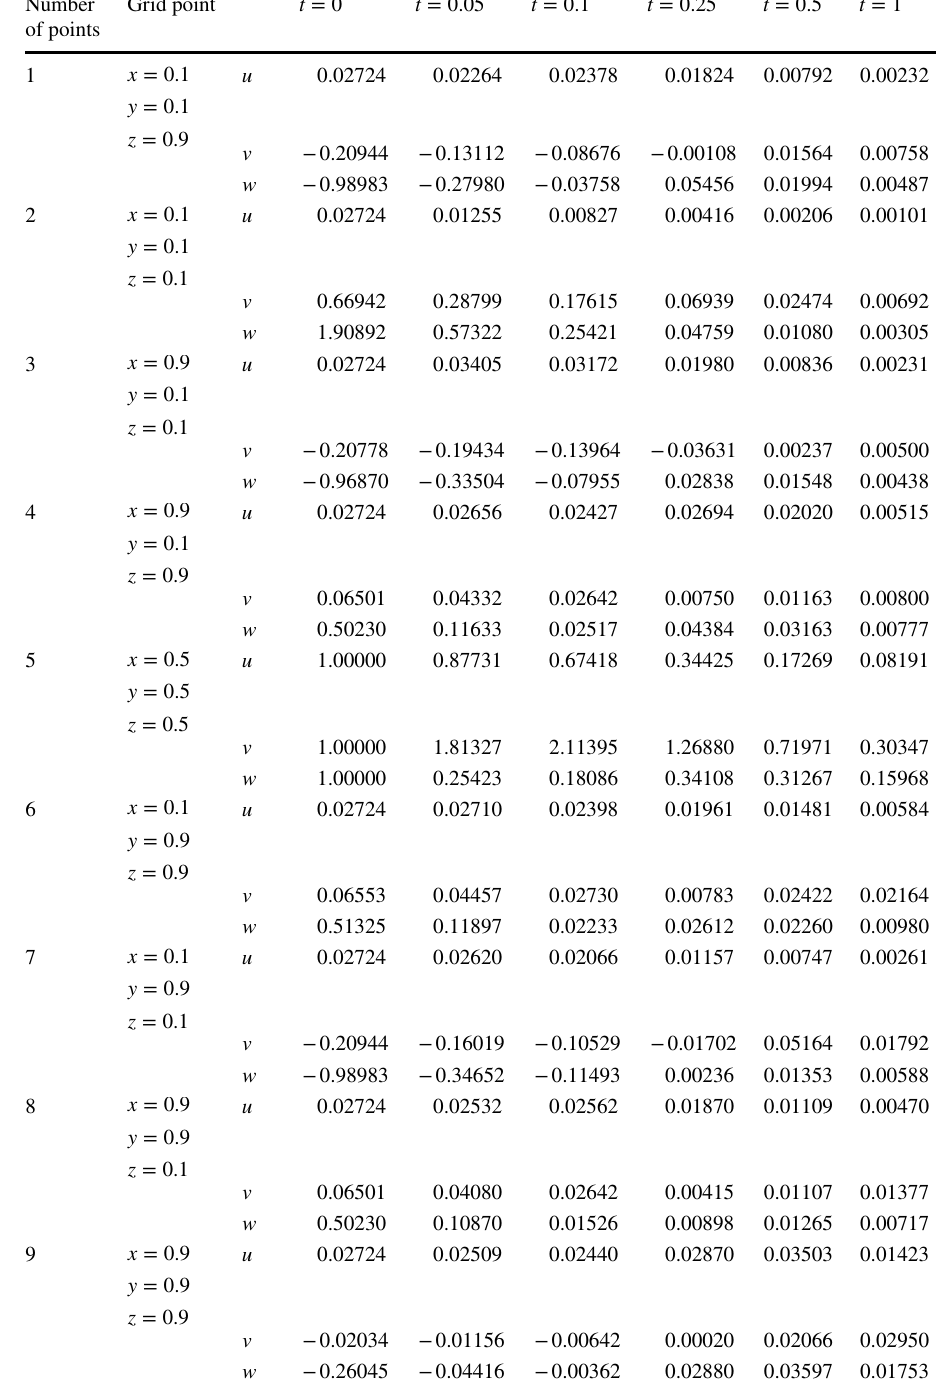
Table 2 A sample of the values of the longitudinal, depth and transverse velocities for nine 𝜐 reagent points, = 0.05 and different